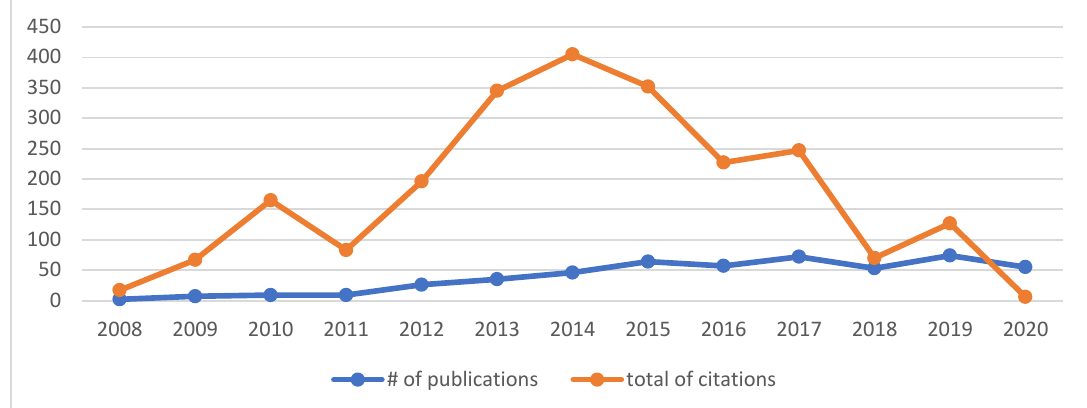
Figure 1. Numbers of publications with and without international collaboration from 2008 to 2020. Figure 2. Total numbers of publications and citations from 2008 to 2020. Figure 2. Total numbers of publications and citations from 2008 to 2020.